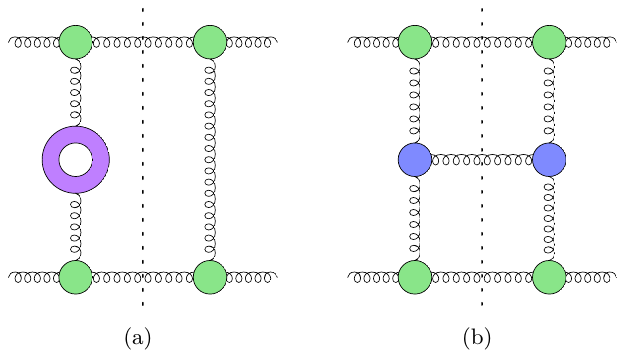
Figure 1 . Interference diagrams which contain the building blocks required for constructing the BFKL equation at LL accuracy: (a) gluon Regge trajectory at one loop; (b) one-gluon central emission vertex at tree level. Tree-level impact factors (shown in green) are required for the computation of cross sections, but are not required to determine the evolution of the t -channel Reggeon.